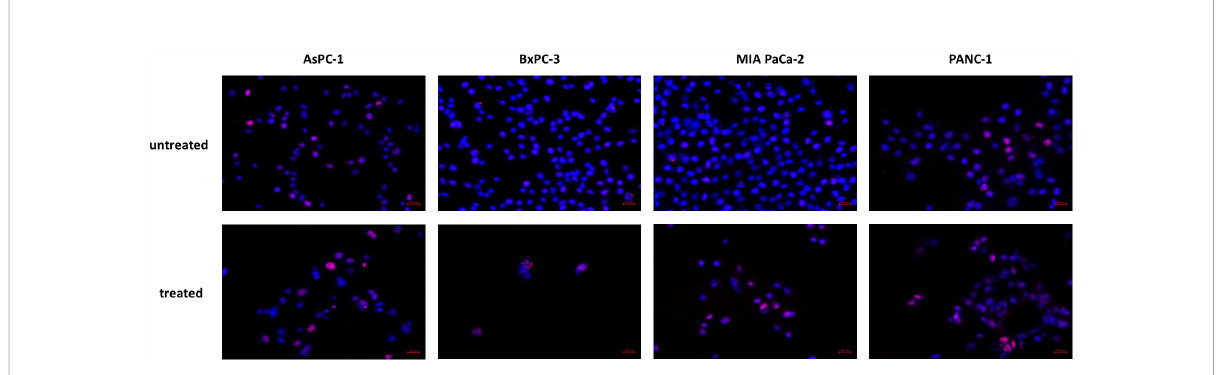
FIGURE 8 Histone H2A.X phosphorylation. Increased phosphorylation of Histone H2A.X was detected after JNK-in-IX treatment. Representative pictures are shown at 40x magni fi